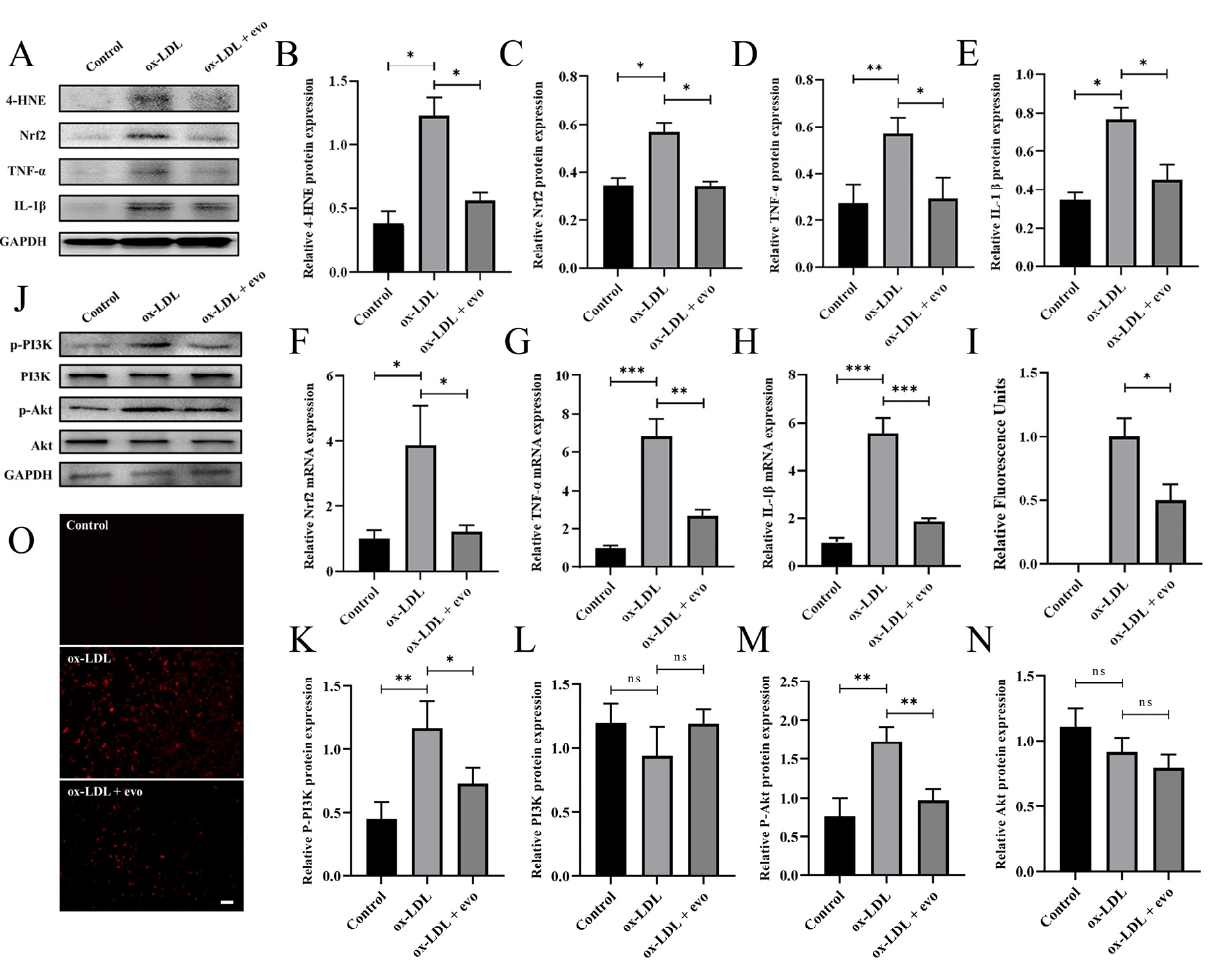
Figure 5. Analysis of inflammatory response and oxidative stress levels of atherosclerotic VSMCs in mice: ( A – E ) representative images ( A ) and data of the protein levels of 4-HNE ( B ), Nrf2 ( C ), TNF- α ( D ), and IL-1 β ( E ). ( F – H ) The expression of Nrf2 , TNF- α , and IL-1 β was quantified by qPCR and standardized to GAPDH. ( I , O ) ROS fluorescence detection (red) and quantification. Scale bar 100 µ m. ( J – N ) Representative images ( J ) and data of the protein levels of P-PI3K ( K ), PI3K ( L ), P-Akt ( M ), and Akt ( N ). The bar graphs depict means ± SEM; statistical significance * p < 0.05, ** p < 0.01, and *** p < 0.001 and ns by the one-way ANOVA test.